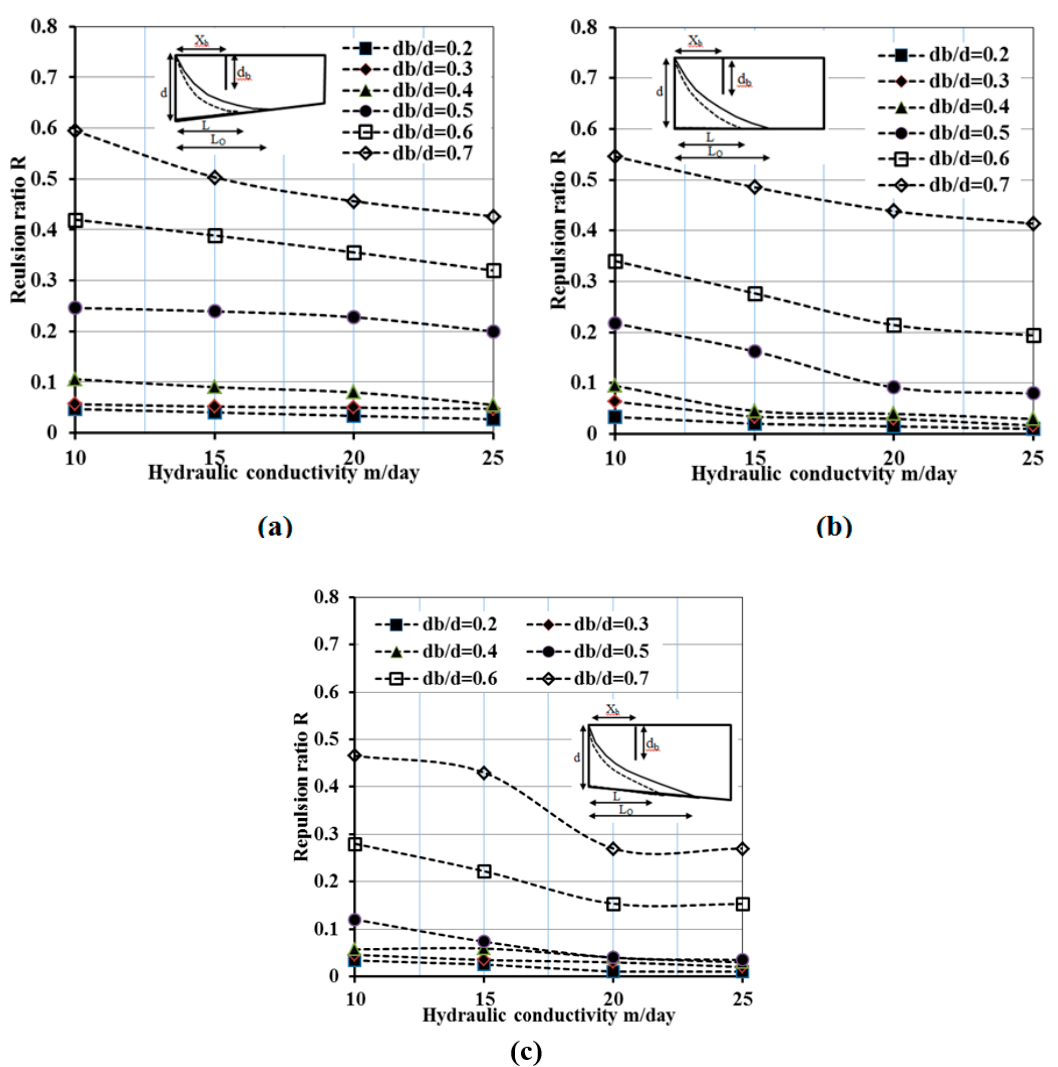
Figure 8. Relationship between hydraulic conductivity and R for different bed slopes tan β : ( a ) 0.02, ( b ) 0.0, and ( c ) − 0.02.